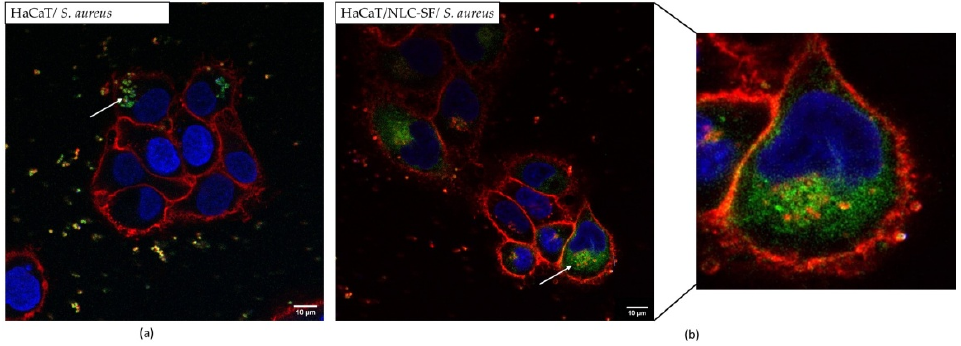
Figure 12. Cellular internalization ( a ) HaCat cells in the presence of SA-GFP; ( b ) HaCaT cells in the presence of S. aureus and NLC-SF; HaCaT were first in contact with S. aureus for 1 h and then 3 h of NLC exposure; NLC-SF dilution D = 50.